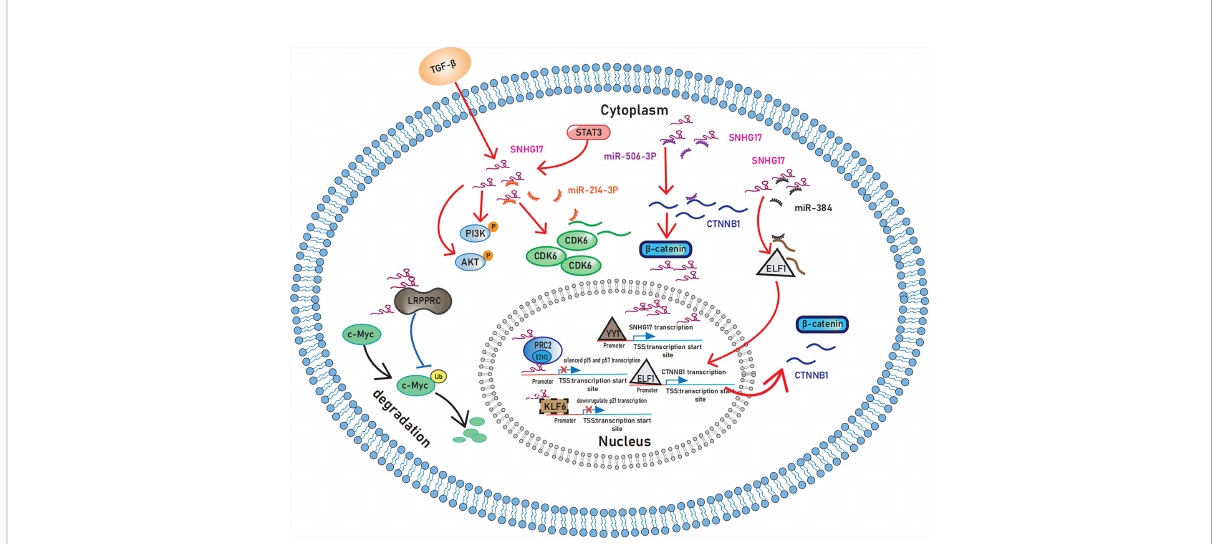
FIGURE 1 Schematic representation of the mechanisms by which SNHG17 plays in sustaining proliferative signaling. In the cytoplasm, SNHG17 acts as the ceRNA for miR-506-3 and miR-384 to activate the Wnt/ b -catenin pathway and enhance the expression of CDK6 by targeting miR-214-3p. Moreover, STAT3 and TGF- b activate the PI3K/AKT signaling pathway by increasing SNHG17 levels. By interacting with LRPPRC, SNHG17 can also reduce c-Myc ubiquitination. In nucleus, SNHG17 targets p57 and p15 by binding to EZH2 and PRC2. p21 may also exist downstream of SNHG17 considering the regulatory relationship between KLF6 and SNHG17. And transcription factor YY1 upregulate the transcription of SNHG17. SNHG17, lncRNA small nucleolar RNA host gene 17; CDK6, Cyclin-dependent kinase 6; STAT3, Signal transducer and activator of transcription 3; TGF- b , Transforming growth factor b ; PI3K, Phosphoinositide-3 kinase; AKT, Protein kinase B; LRPPRC, Leucine-rich pentatricopeptide repeat-containing protein; EZH2, enhancers on zeste homolog 2; PRC2, Polycomb repressive complex 2; KLF6: Krupple-like factor 6; YY1, Yin-yang